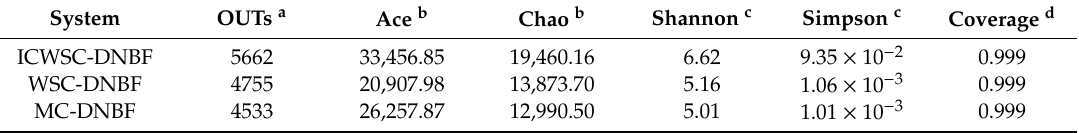
Table 1. Similarity-based OTUs and species richness and diversity estimates for microbial communities in the denitrifying biofilter